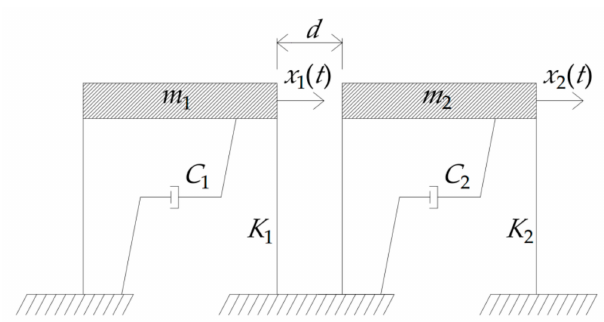
Figure 1. Model of interacting two adjacent single-storey